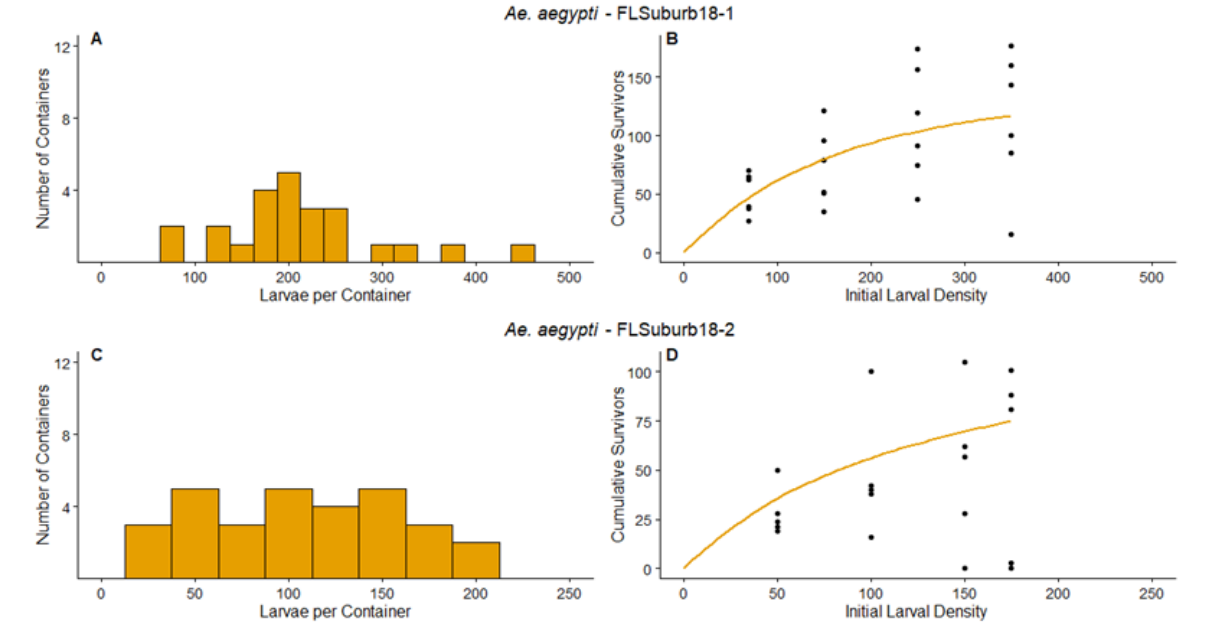
Figure 4. Results for FLSuburb18-1 and FLSuburb18-2 experiments. The left panels are the frequency distribution of mosquito larvae per container at the end of the survey period, ( A ) for FLSuburb18-1, ( C ) for FLSuburb18-2. (Not pictured—one container with 1055 Culex larvae in FLSuburb18-1). The points on the right panels represent the cumulative number of survivors of the density manipulation experiments, ( B ) for FLSuburb18-1, ( D ) for FLSuburb18-2. The lines on the right panel represent the predicted values for the relationship between initial larval density and cumulative survivors, according to the non-linear regression analyses. Orange indicates the experiment was conducted on Ae. aegypti . Axis values vary between experiments.